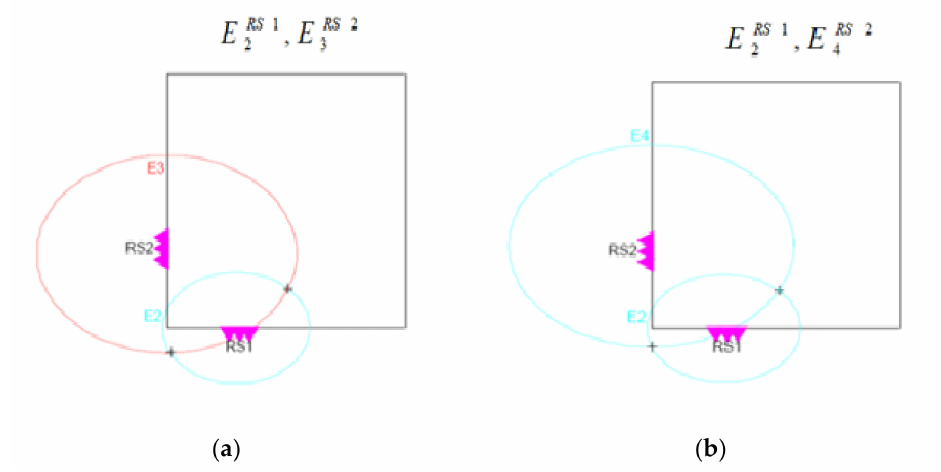
Figure 8. Combined intersections of ellipses: ( a ) E2 sets RS1 and E3 sets RS2 and ( b ) E2 sets RS1 and E4 sets